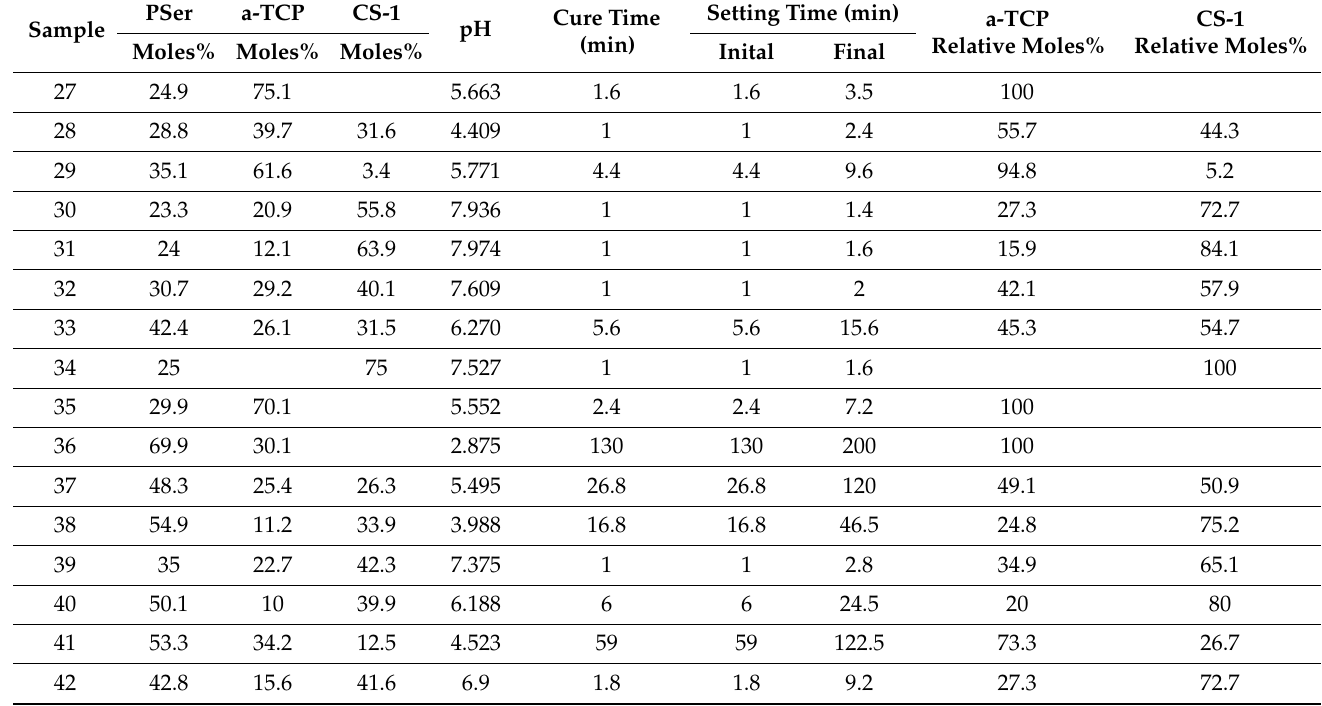
Table 1. Table of disc formulations used for the Alamar Blue, ALP, and ICP experiments, including the setting